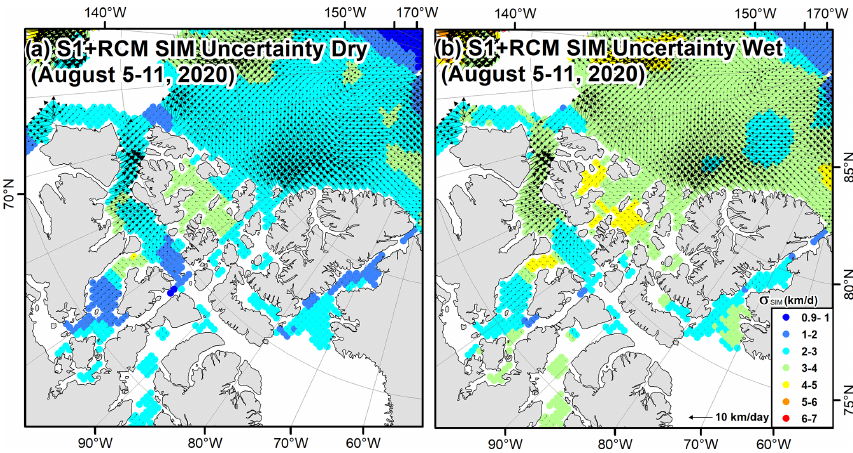
Figure 16. Spatial distribution of (a) dry and (b) wet S1 + RCM SIM uncertainty for 5–11 August